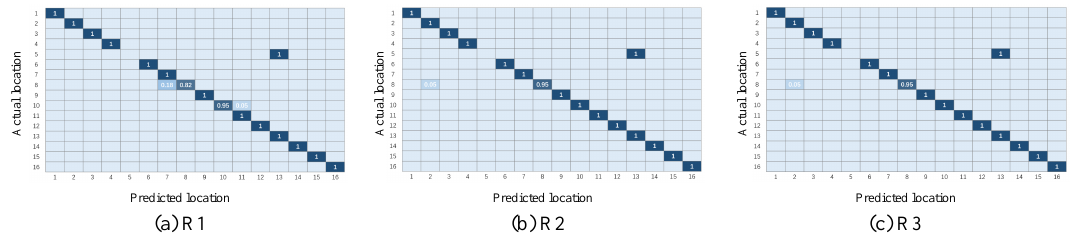
Figure 7. Confusion matrix under different multi-domain representations ( T 1 - T 2 ).